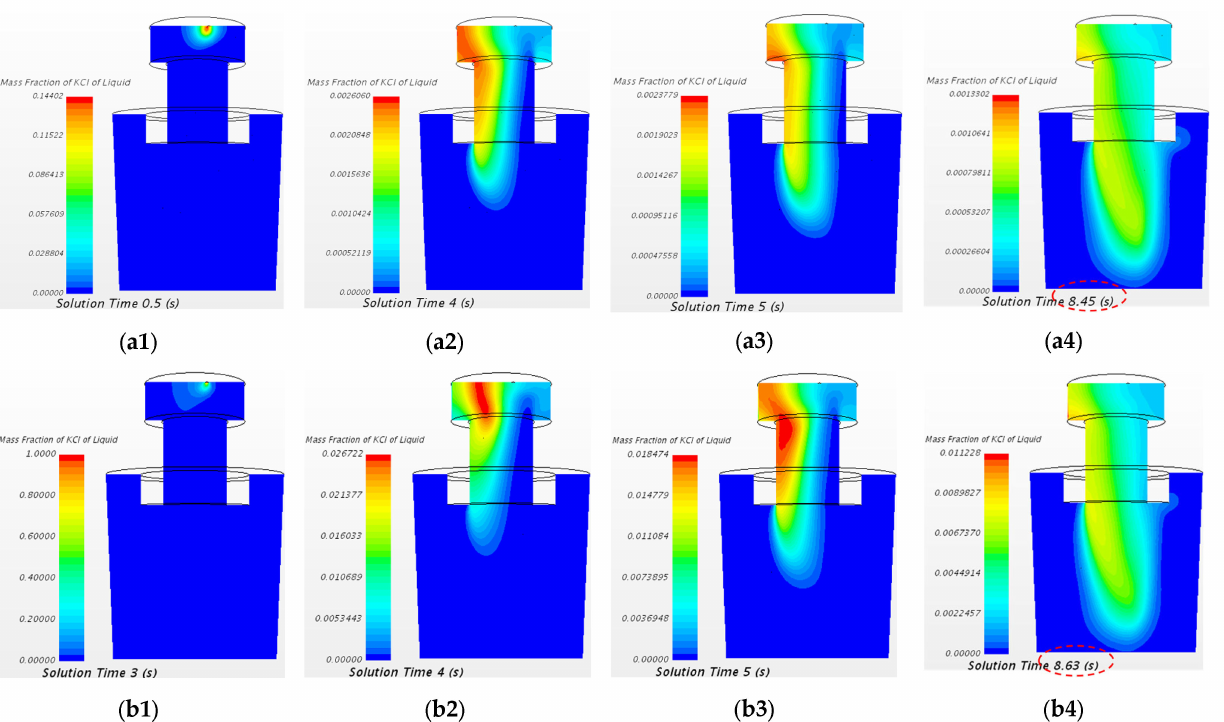
Figure 13. Comparison of mass fraction of KCl tracer of the case of 20 mL KCl tracer and the case of 150 mL KCl tracer at the central longitudinal section of SSRF at different time steps. ( a1 ) 20 mL 0.5 s, ( b4 ) 150 mL 8.63